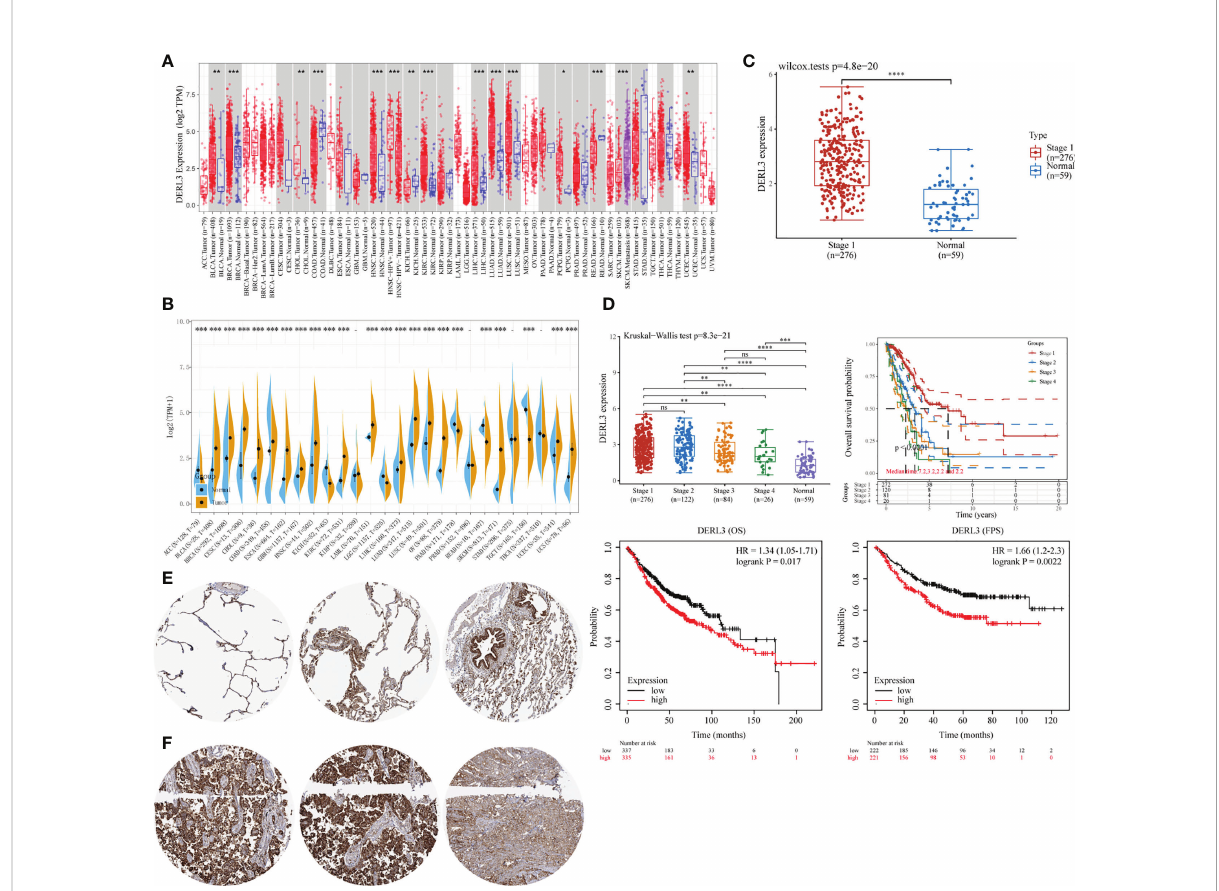
FIGURE 1 Gene expression and prognostic value of DERL3 in LUAD patients. (A, B) Pan-cancer analysis of DERL3 expression across RNA-seq datasets from TCGA. (C) Expression of DERL3 in normal pulmonary and stage I LUAD tissues. (D) Kaplan – Meier analysis of DERL3 expression with overall survival (OS) and fi rst progression (FP) values in LUAD patients. (E, F) Immunohistochemistry of DERL3 expression in normal pulmonary and LUAD tissues based on HPA database. (*p < 0.05, **p < 0.01, ***p < 0.001, ****p < 0.0001, ns, not signi fi